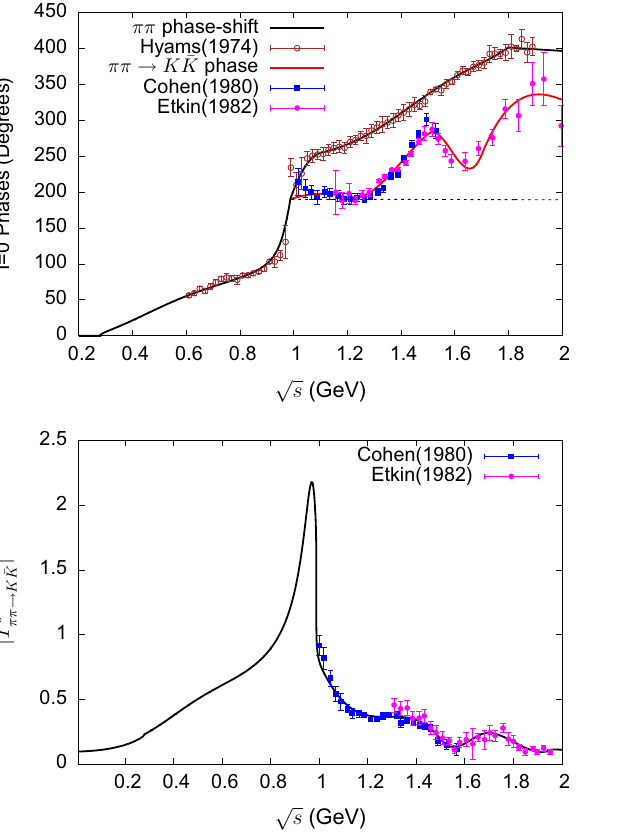
Fig. 3 Illustration of the I = 1 T -matrix. The upper figure shows the ηπ phase shift and the phase of the ηπ → K ¯ K amplitude g ηπ π ). The lower figure shows the modulus of g ηπ